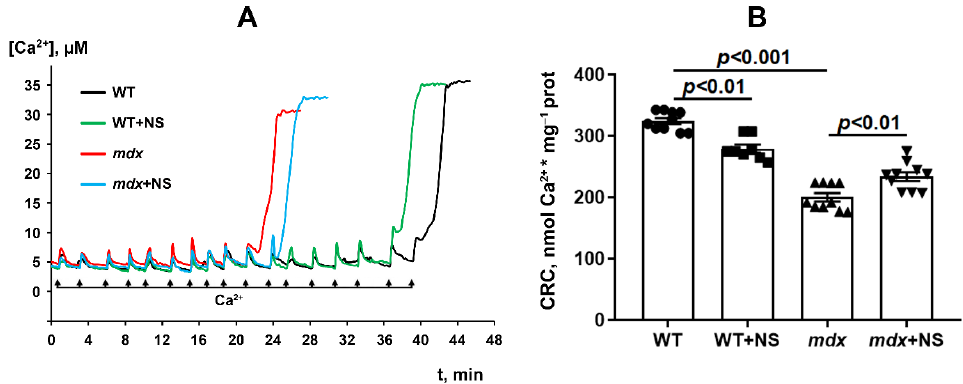
Figure 3. Changes in the external [Ca 2+ ] upon the successive addition of 5 μM Ca 2+ pulses to the suspension of the skeletal muscle mitochondria of the experimental animals ( A ). Ca 2+ retention capacity of skeletal muscle mitochondria ( B ). The data are presented as m ± SEM. MPT pore induction in DMD is thought to be due to a complex interaction between